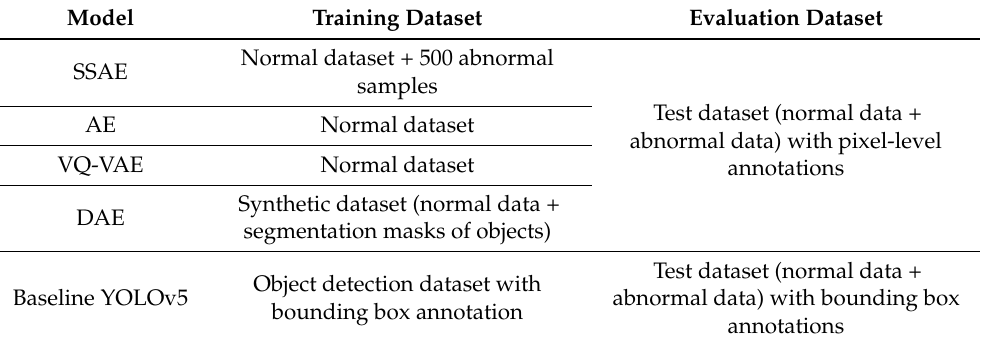
Table 1. Overview of datasets used for the training of autoencoders and baseline